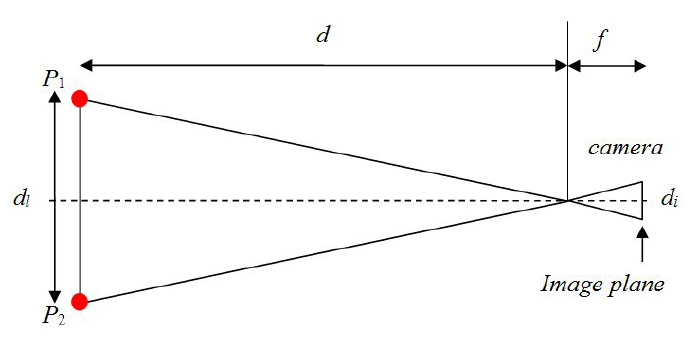
Figure 7. The pairing